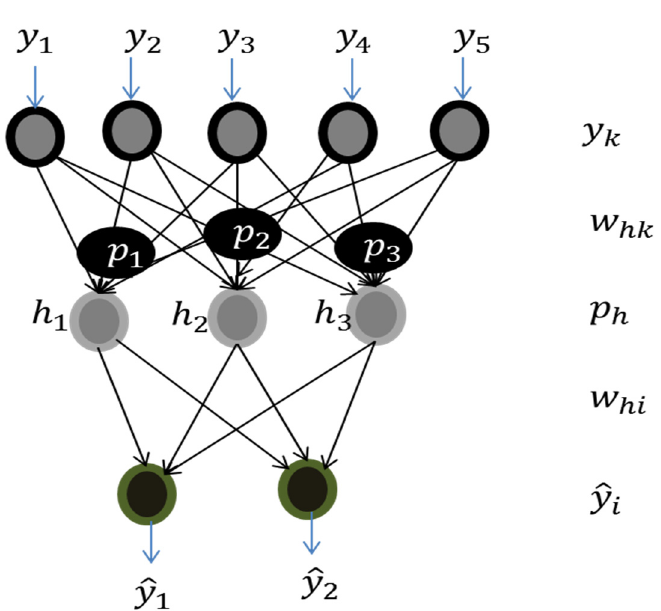
Figure 3. Two most popular pooling methods.